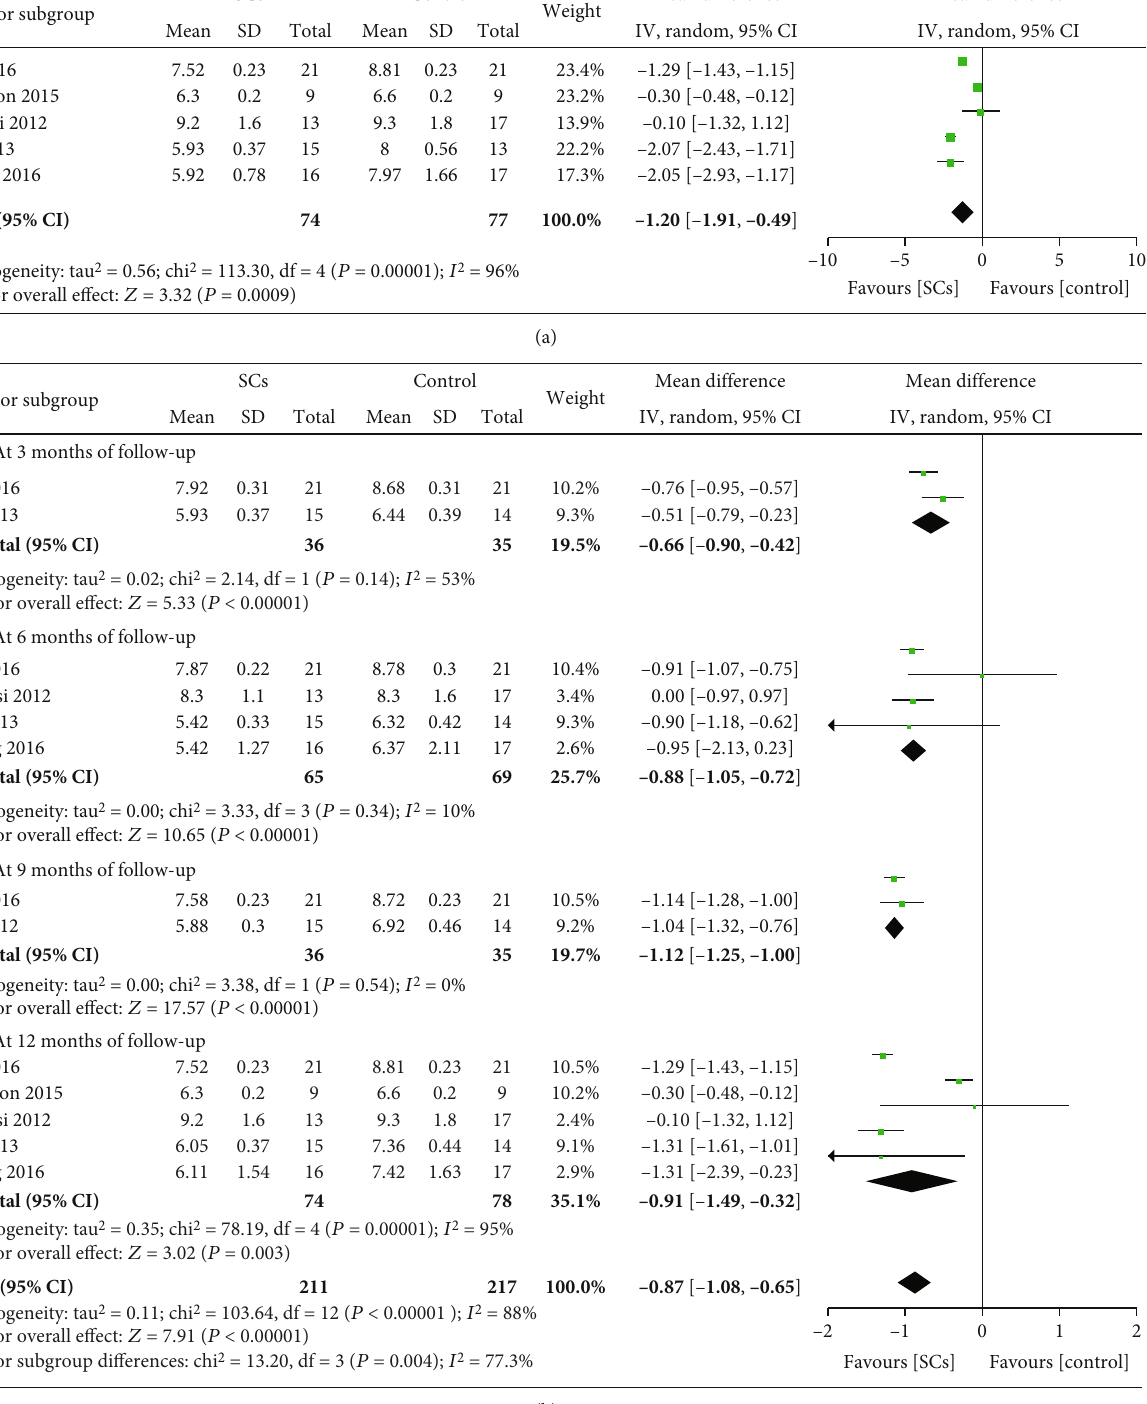
Figure 2: HbA1c levels at the longest follow-up (a). HbA1c levels at di ff erent follow-up (b)